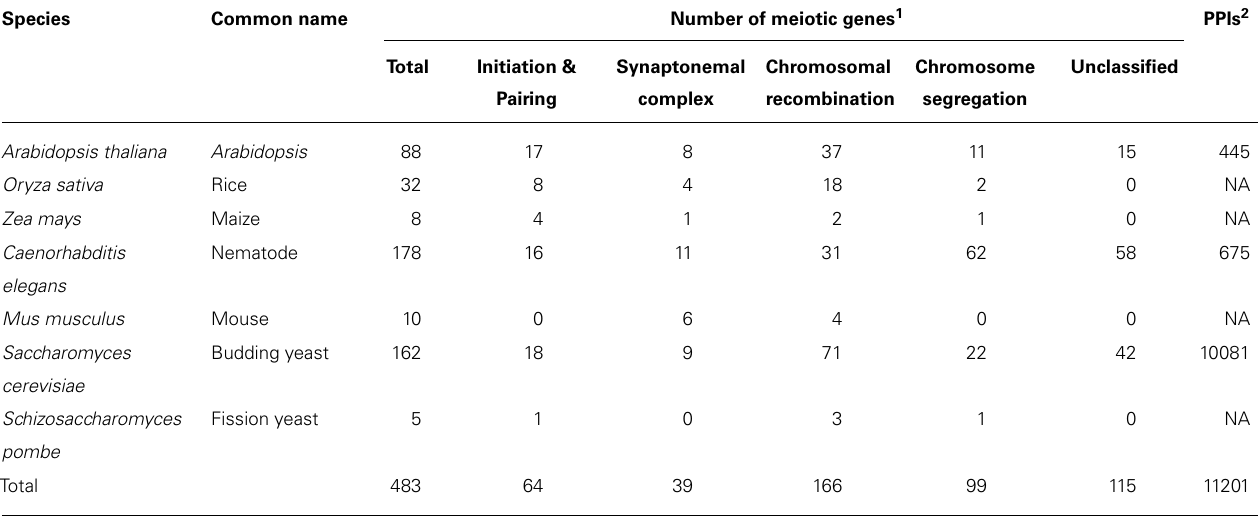
Table 1 | Data status in the current